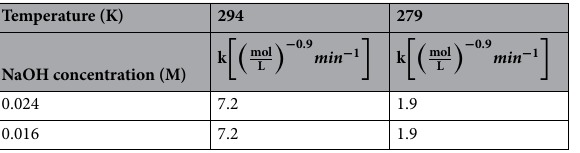
Table 2. Actual rate constant at variable reaction temperature and NaOH